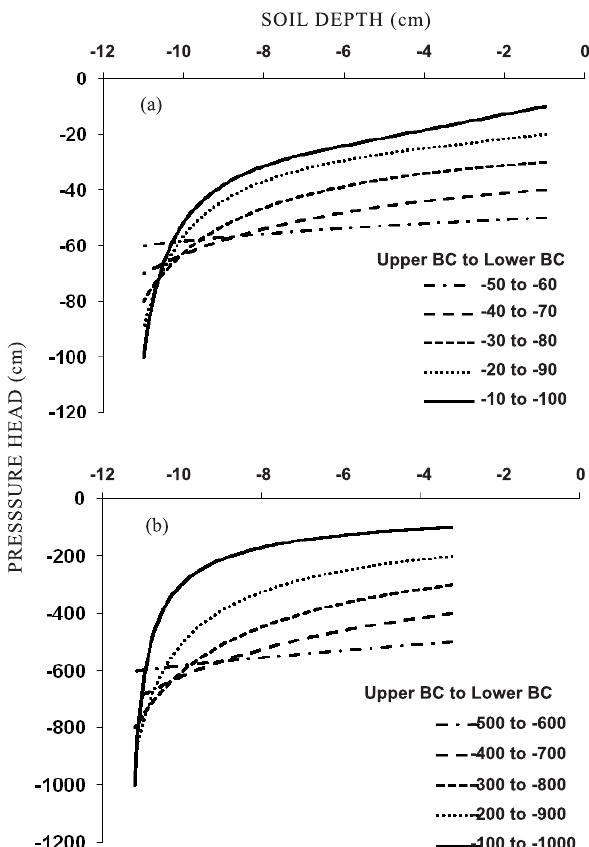
Figure 2. Pressure head distribution as related to depth in the pure phase Clay Loam system. Near- saturation range (a) and drier range